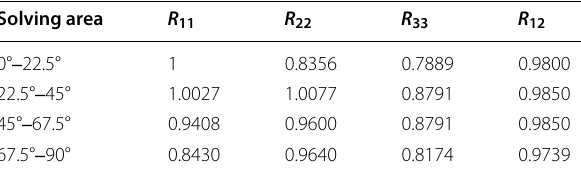
Table 4 Four specified material parameters for using the Hill48 yield function in Abaqus Solving area